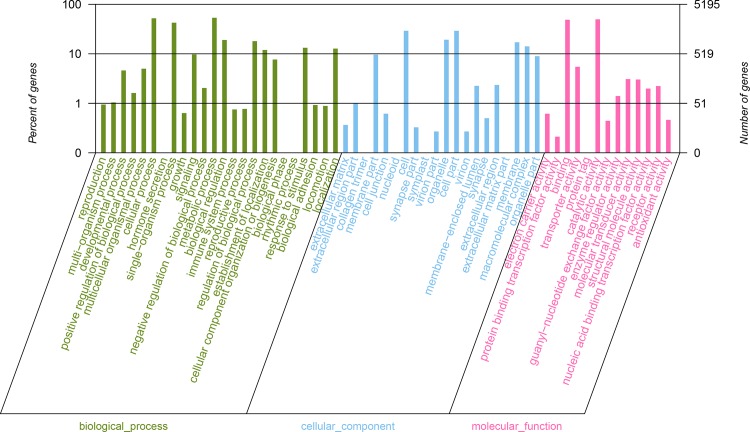
Gene ontology (GO) category of the unigenes.5,195 annotated unigenes were classified into 3 functional categories: molecular_function, biological_process and cellular_component.